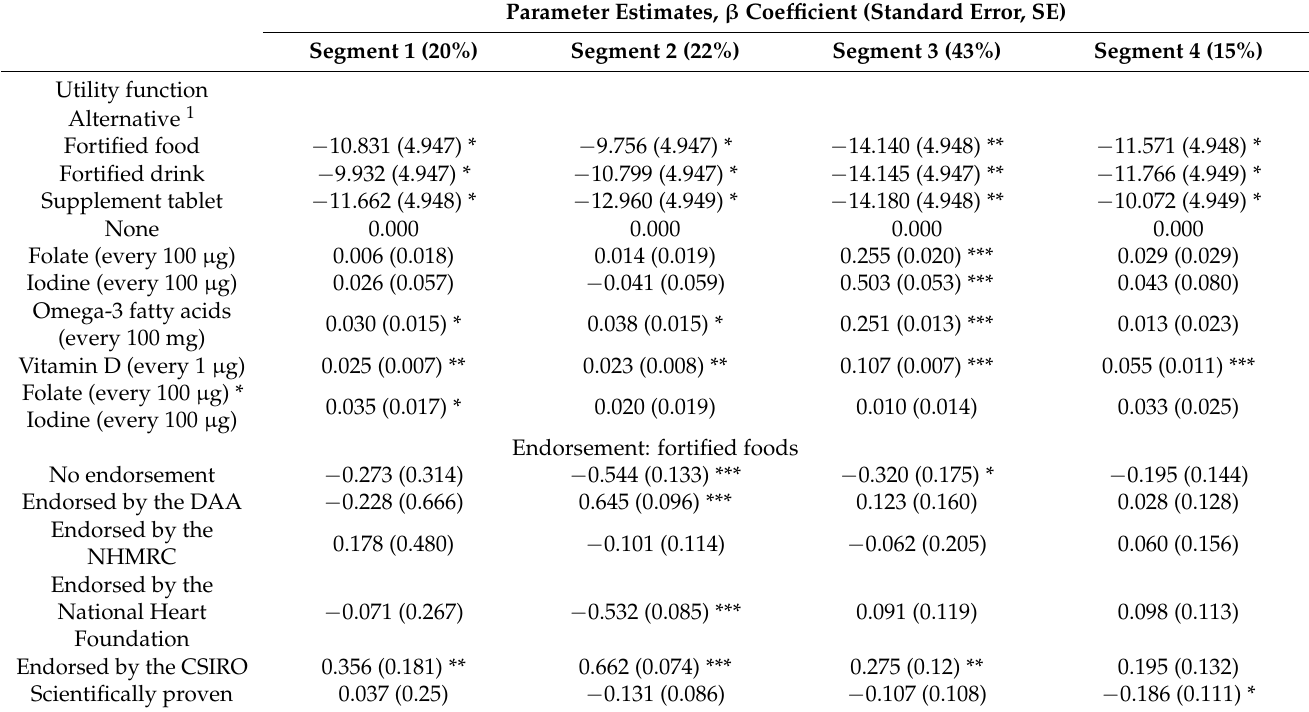
Table 4. Preference coefficients for the four segments of pregnant women ( n =